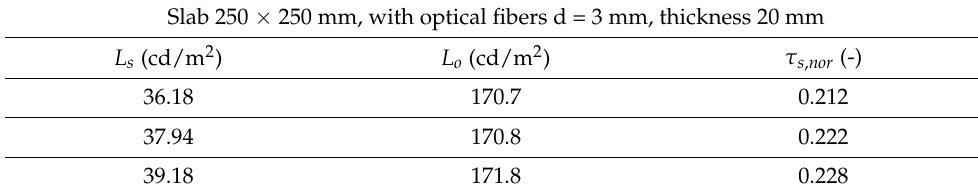
Values of the light transmission factor when measured against a white wall in the